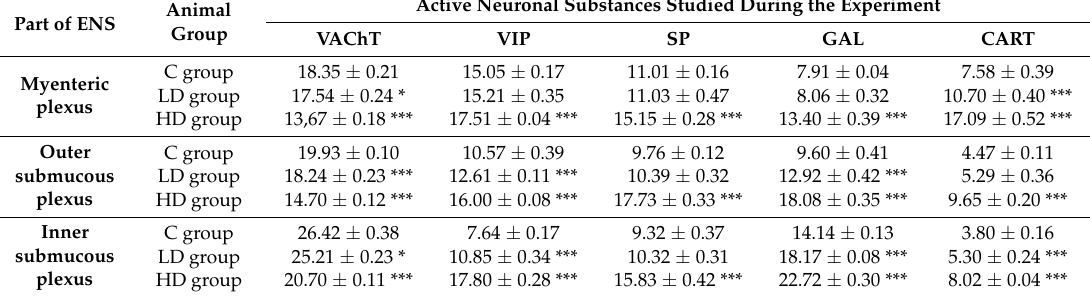
Table 1. The percentage (mean ± SEM) of neurons showing the presence of the chosen neuronal active substances.